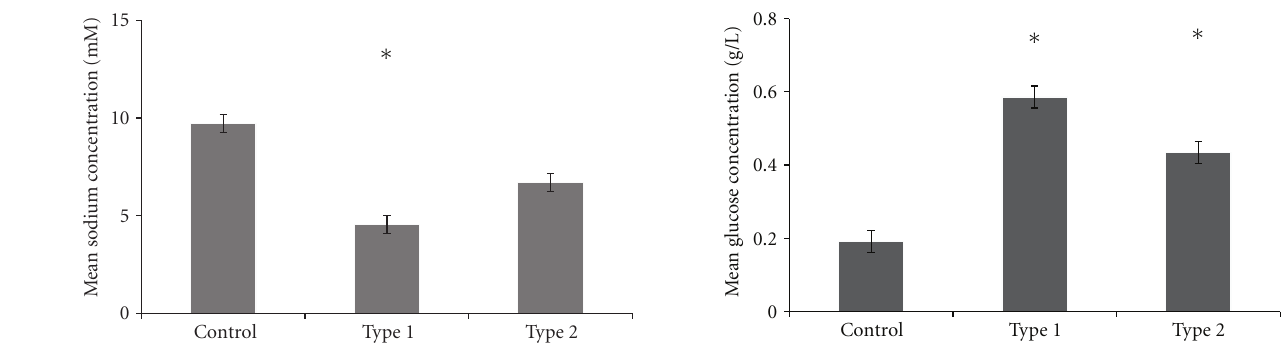
Figure 3: Mean sodium content of milk in each group. ∗ indicates significant di ff erence ( P < 0 . 05) compared to control mothers.